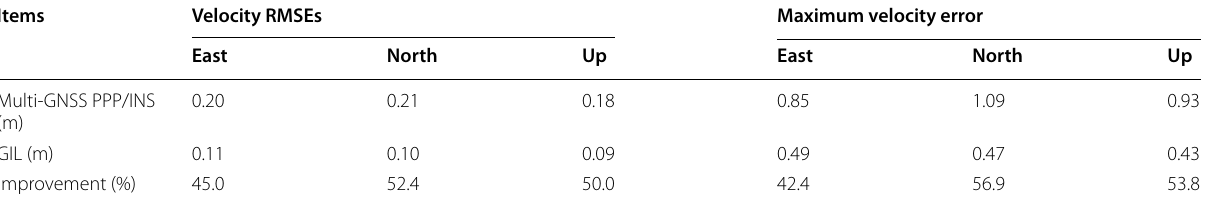
Table 8 RMSEs and maximum error of velocity for PPP/INS and GIL solutions in GNSS difficult